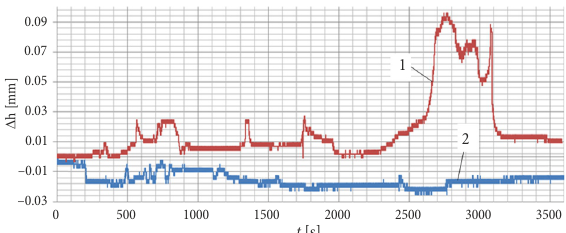
Fig. 11. Curves of variation of specimen width in the medium of liquid nitrogen (explanations are given in the